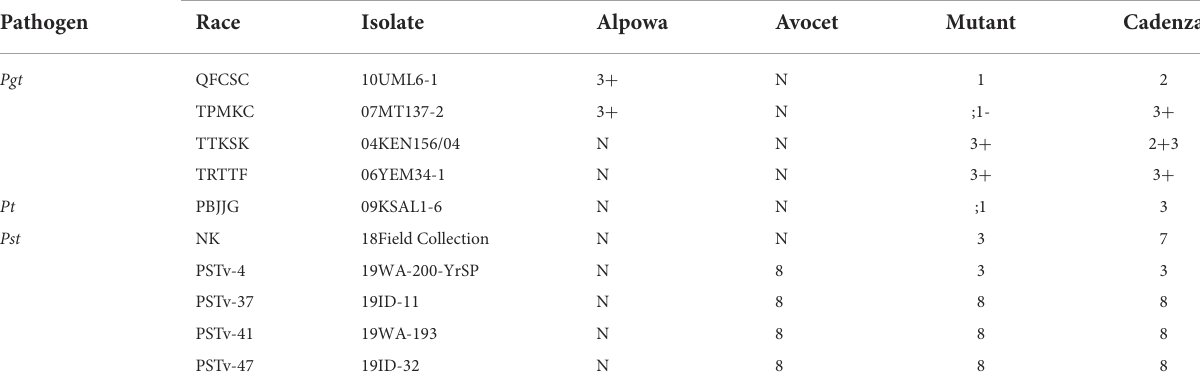
TABLE 2 Rust evaluations of Cadenza L683F mutant and wild-type Cadenza.